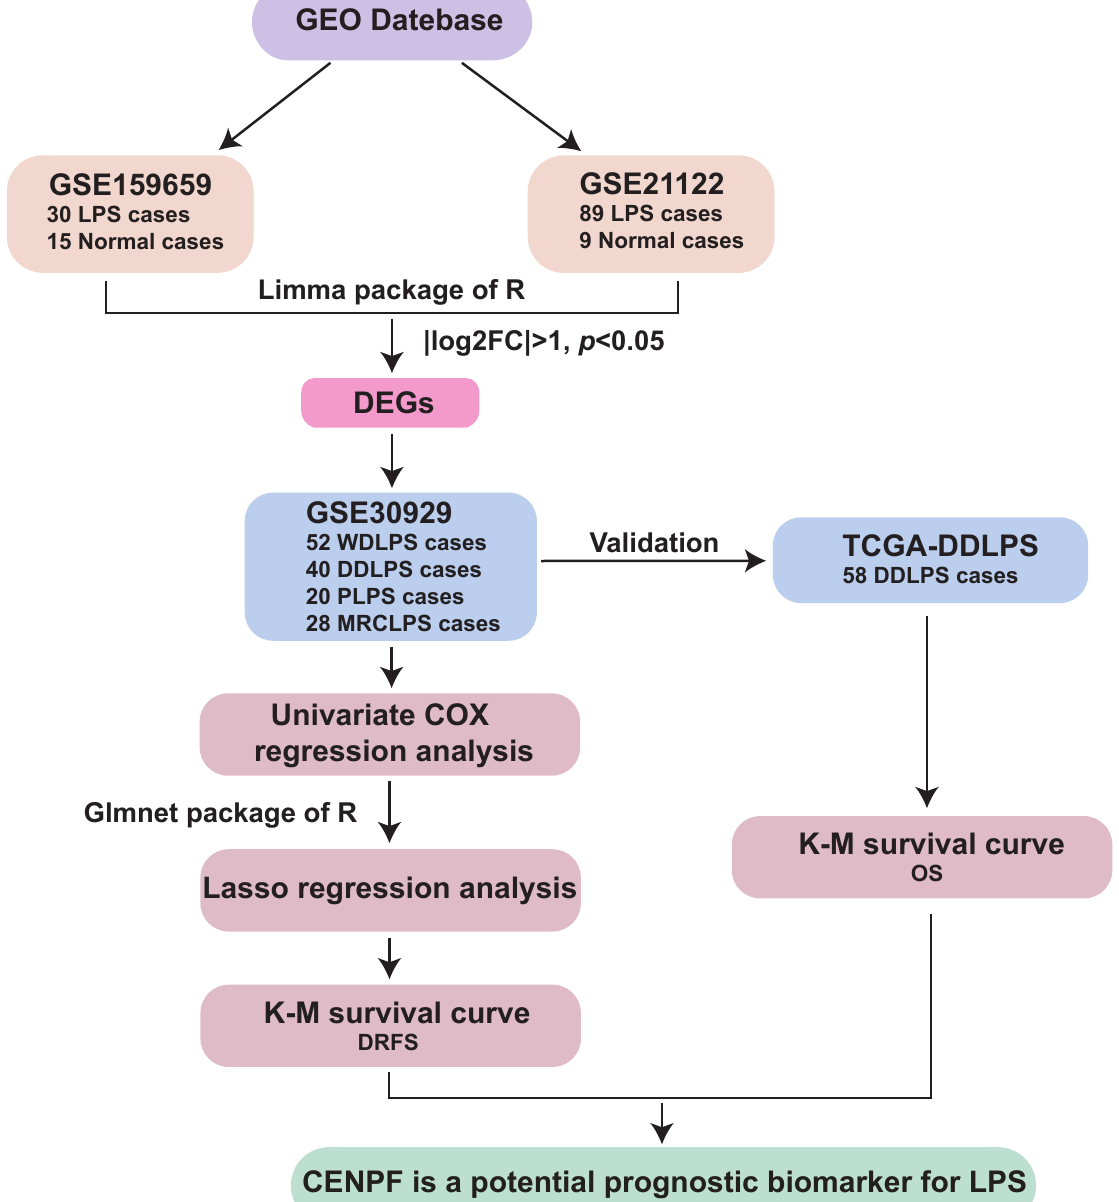
Figure 1. Schematic diagram of candidate genes screening for LPS prognostic biomarkers. By analyzing the CENPF CNAs of LPS patients, the relationship between CENPF expression and CNAs was observed: CENPF expression in patients with a single copy deletion (n = 20) significantly decreased ( p < 0.001) compared with diploid normal copy (n = 35) cases (Figure